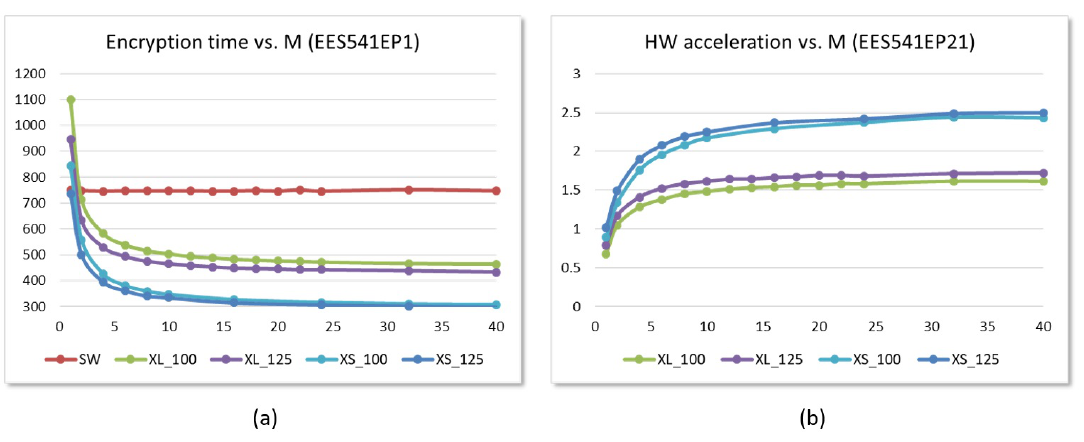
Figure 20. Evolution versus number of AUs of the time invested ( a ) and the acceleration factor reached ( b ) in the encryption operation using the set of parameters EES541EP1 for SW and HW/SW embedded systems implemented on the Pynq-Z2 board (time displayed in µ